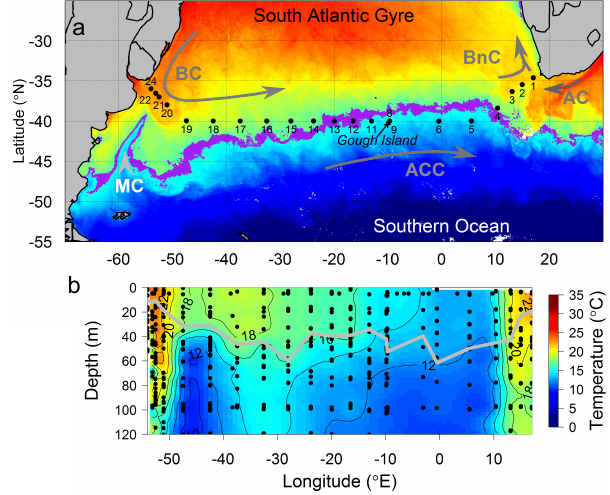
Fig. 1. Water temperature around the Atlantic SSTC. (a) MODIS monthly composite image of sea-surface temperature (SST) for Jan- uary 2012. Dominant surface water masses and sampling stations are labelled (AC: Agulhas Current; ACC: Antarctic Circumpolar Current; BC: Brazil Current; BnC: Benguela Current; MC: Malv- inas (Falklands) Current). Purple colouring represents SST = 16 ◦ C ( ± 0.5 ◦ C) and is shown as a practical definition of the SSTC lo- cation. Gough Island is located next to Station 9. (b) Cross-basin section of CTD water temperature. Grey line indicates the mixed layer depth